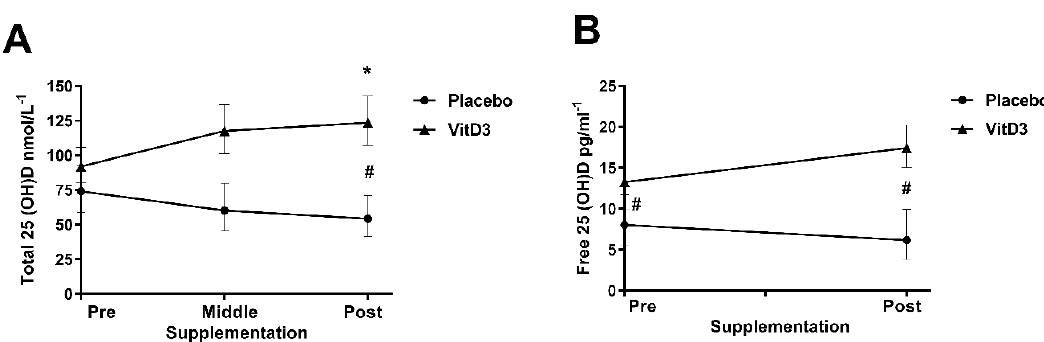
Figure 2. Serum total 25(OH)D concentration pre-, middle- and post-supplementation ( A ) and free 25(OH)D concentration pre- and post-supplementation ( B ). * Di ff erence within group (VitD3 pre-supplementation vs. VitD3 post-supplementation by ANOVA; p = 0.01); # di ff erence between groups (VitD3 pre- and post-supplementation vs. placebo pre- and post-supplementation; p < 0.001).